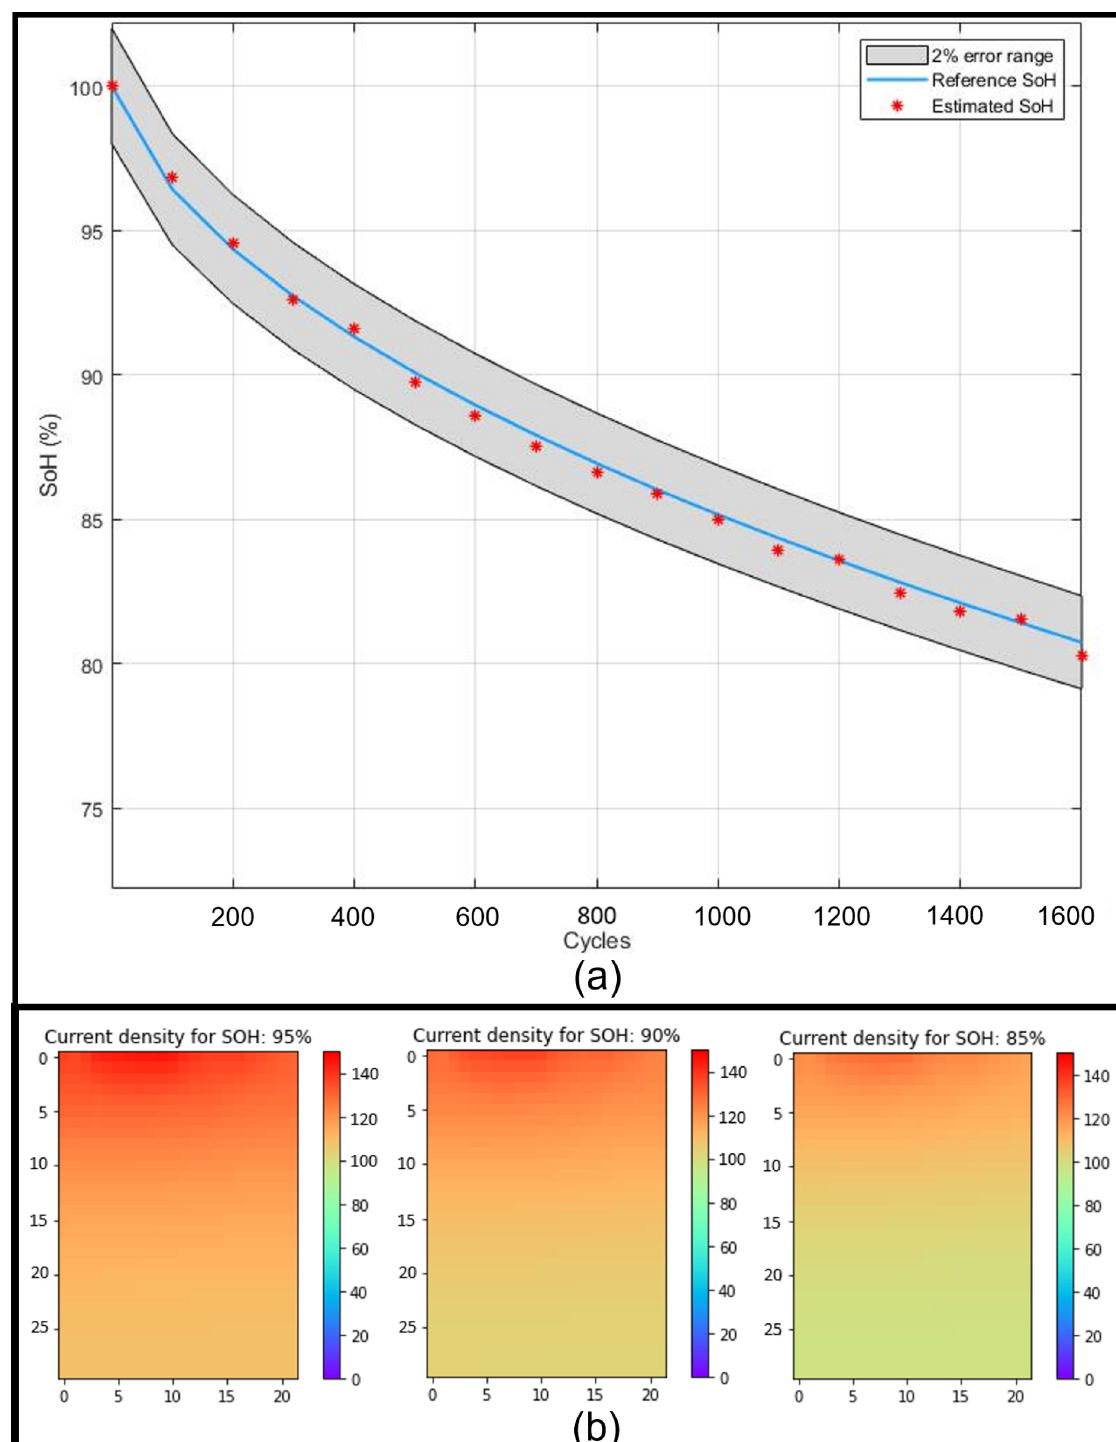
Figure 11. ( a ) SoH(%) estimation results for a new cell. ( b ) Captured CDIs from the new